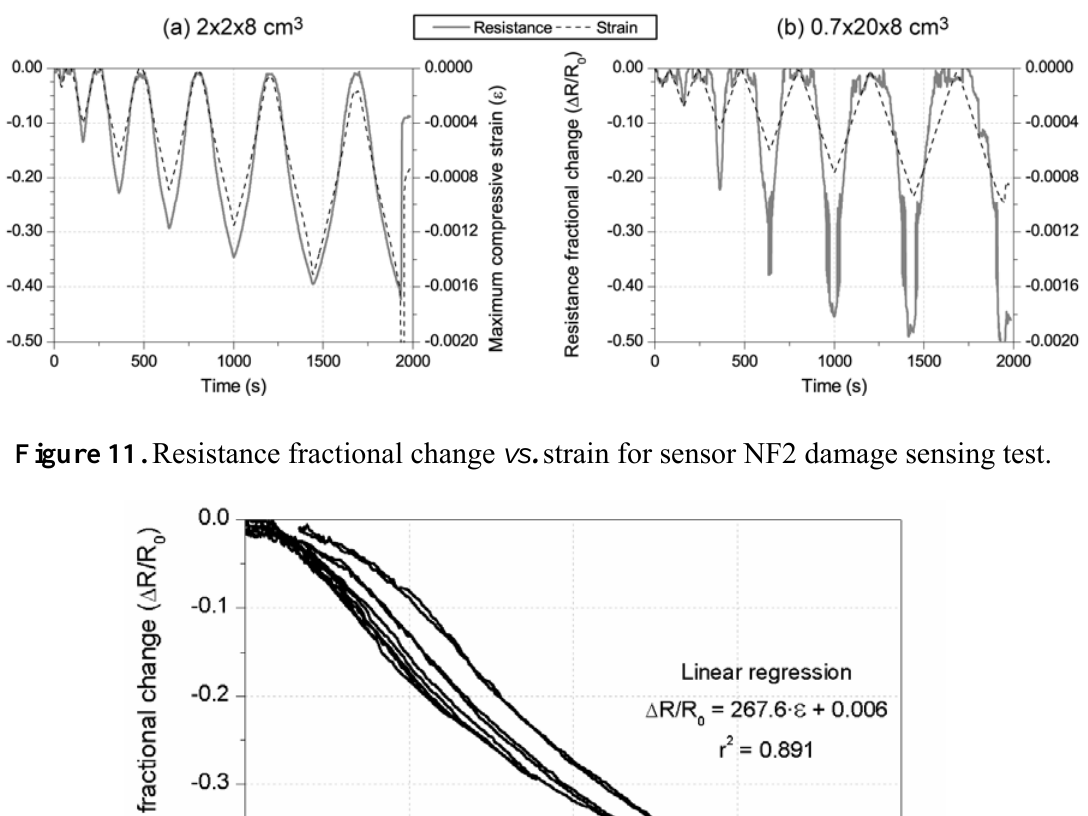
Figure 10. Damage sensing test for sensors NF2 ( a ) and NF4 ( b ), Resistance fractional change and longitudinal strain at sensor’s location are represented, both vs. time.